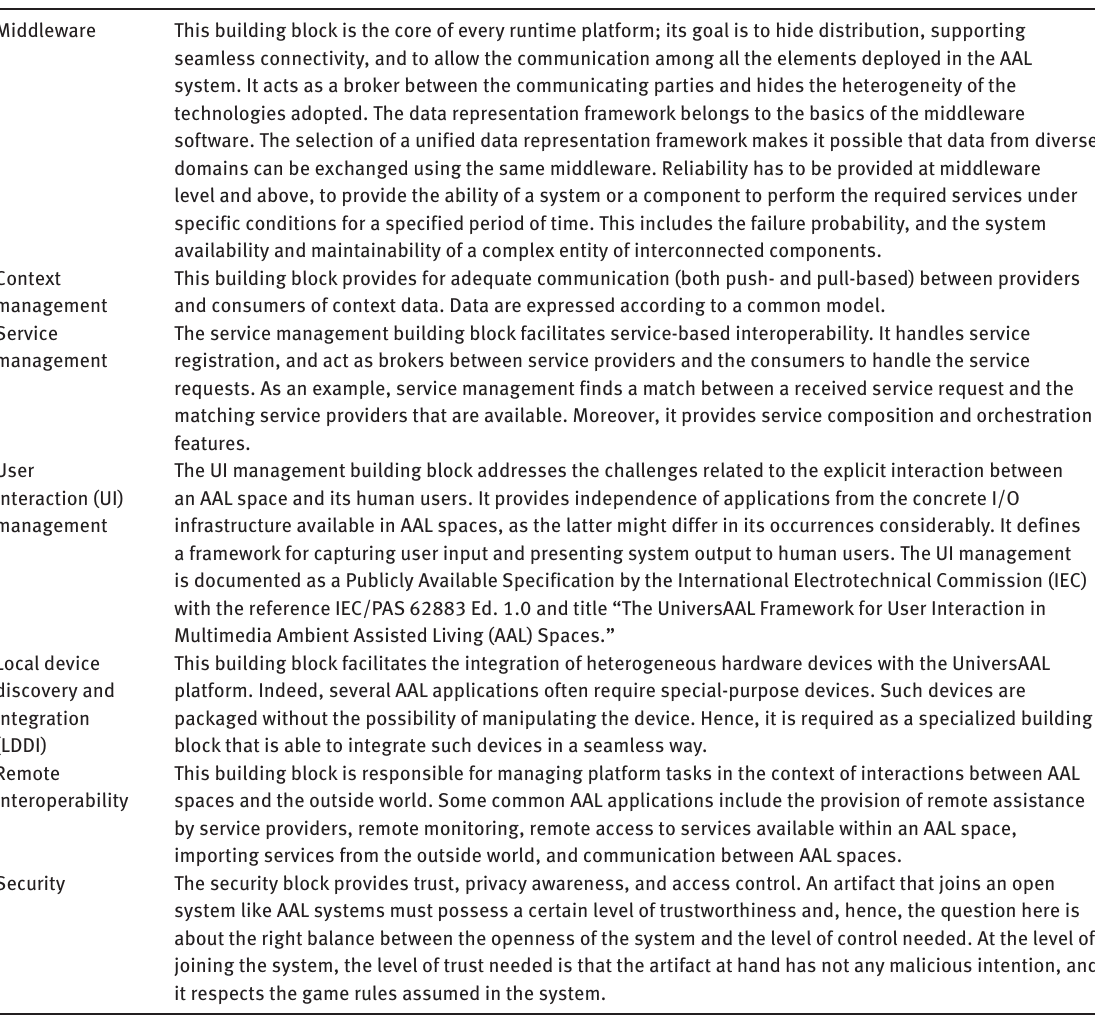
Table 3: The Building